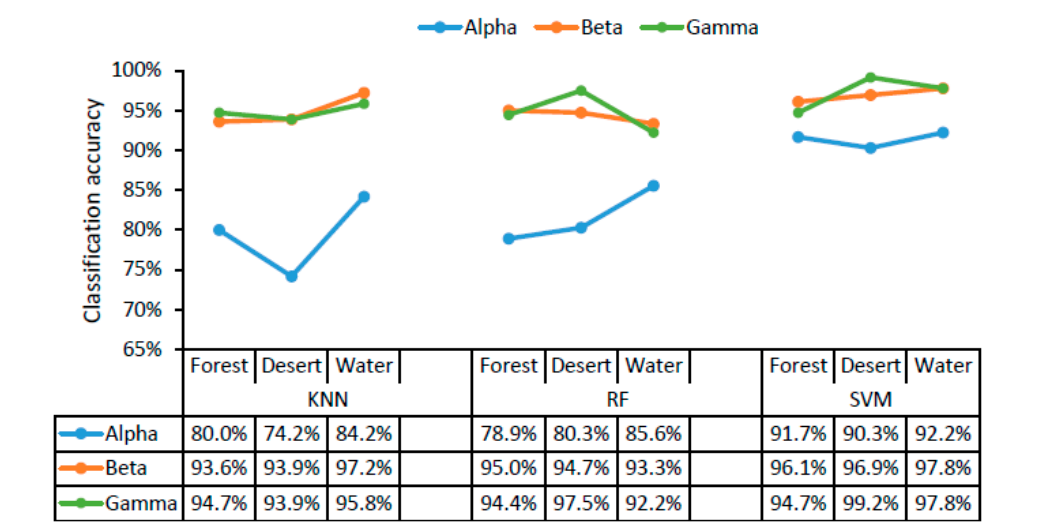
Figure 4. The accuracy of classifying landscape types (forest, desert, and water). KNN, K-nearest neighbor; RF, random forest; SVM, support vector machine.